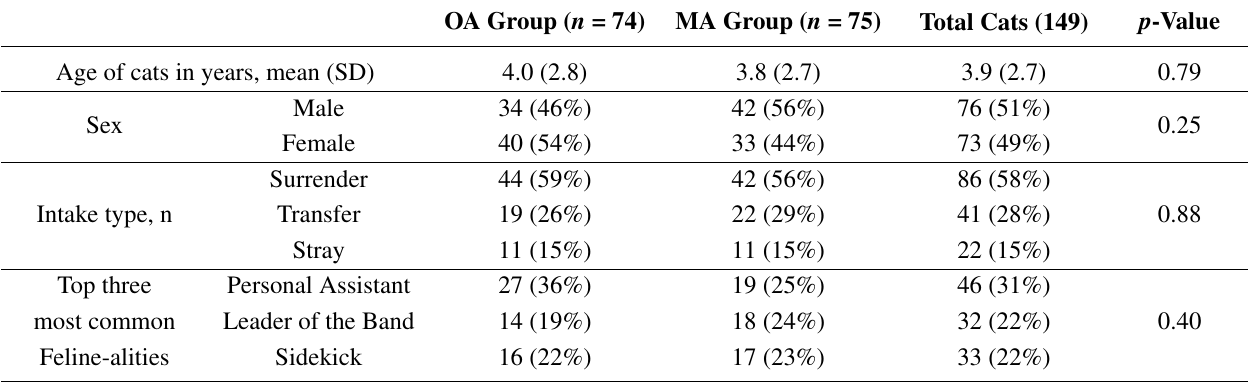
Table 3. Demographic and Feline-ality™ data comparing cats in the OA and MA